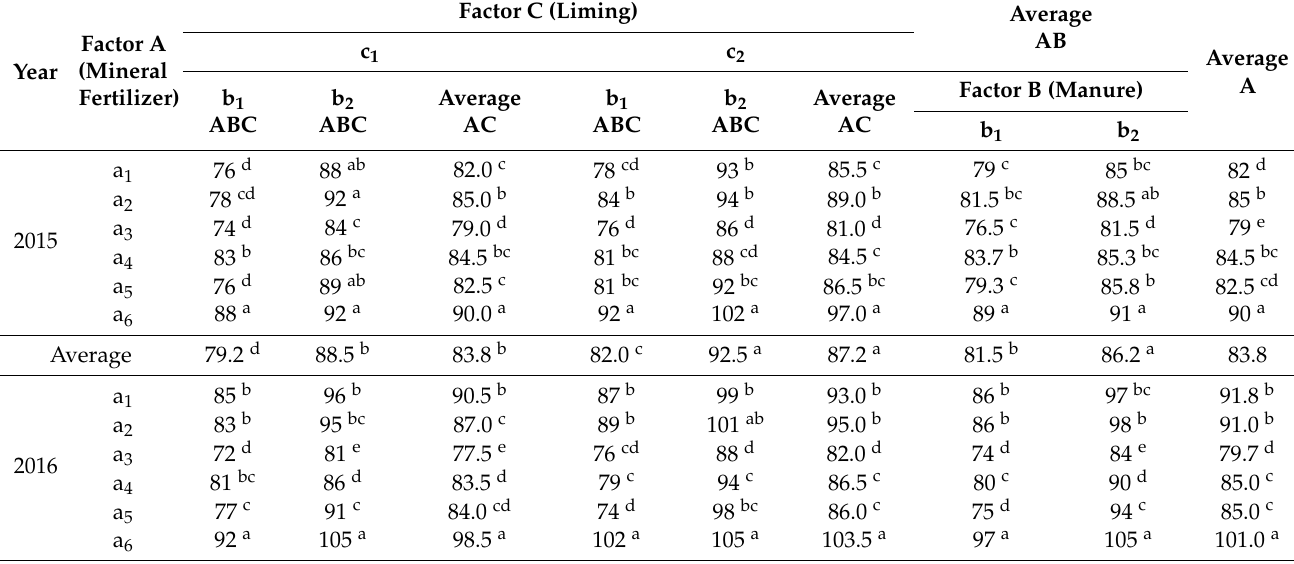
Table 5. The influence of the applied fertilizers on average tuber weight